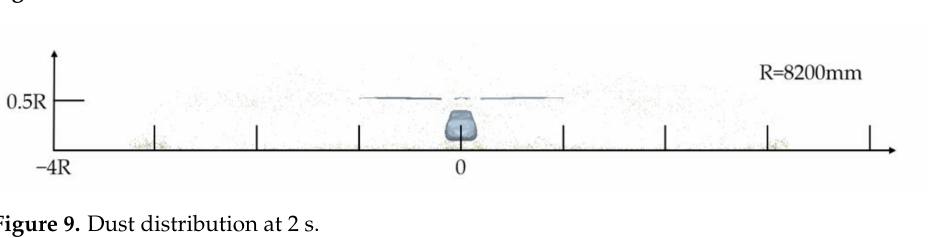
Figure 8. Dust distribution at 1 s.